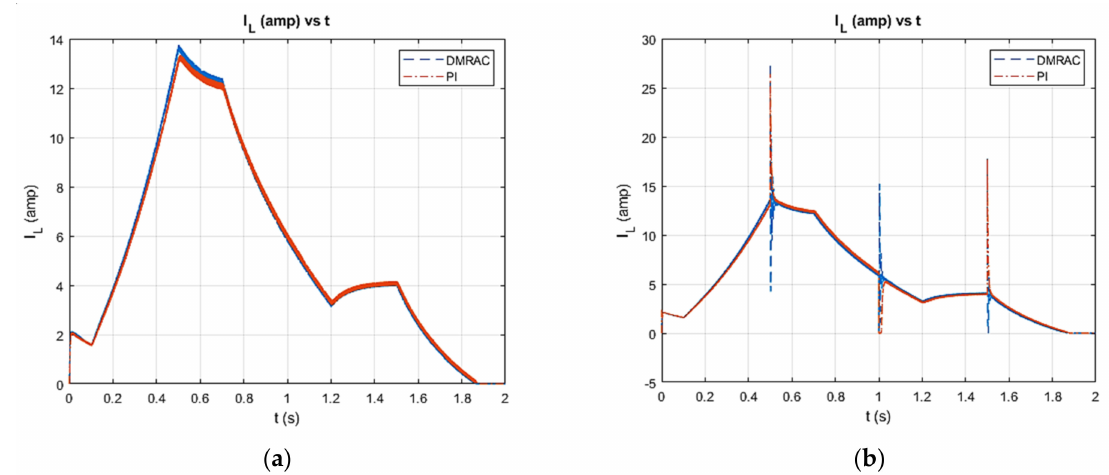
Figure 7. Inductor current ( a ) without the disturbance in the system and ( b ) in presence of the disturbance in variable voltage tracking.